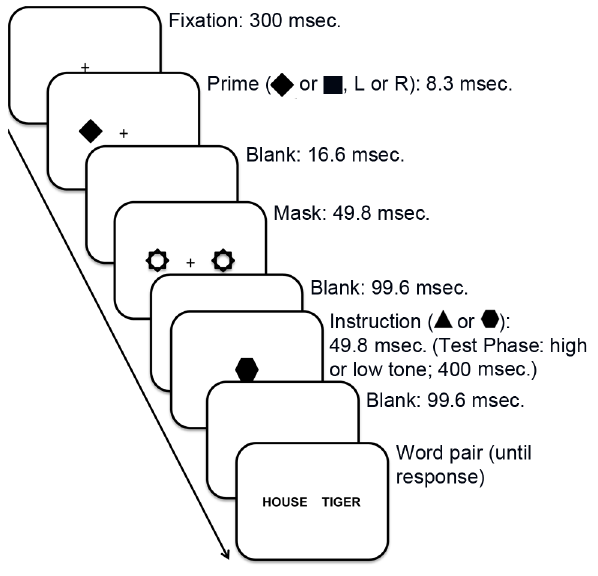
Figure 1. Sequence of events in each trial of the Training, Test and Generalization Phases. A central fixation cross was presented for 300 msec. followed by a diamond or square prime to the left or right of fixation for 8.3 msec. Following a blank screen of 16.6 msec duration two masks were presented in both of the potential prime locations and remained on screen for 49.8 msec followed by a blank screen of 99.6 msec. The conscious instruction was then presesented. In the Training Phase this consisted of a central black triangle or hexagon for 49.8 msec. In the Test and Generalization Phases this was replaced by a high or low tone of 400 msec. duration. Following a further blank screen of 99.6 msec., the word pair was presented which remained on screen until a response was